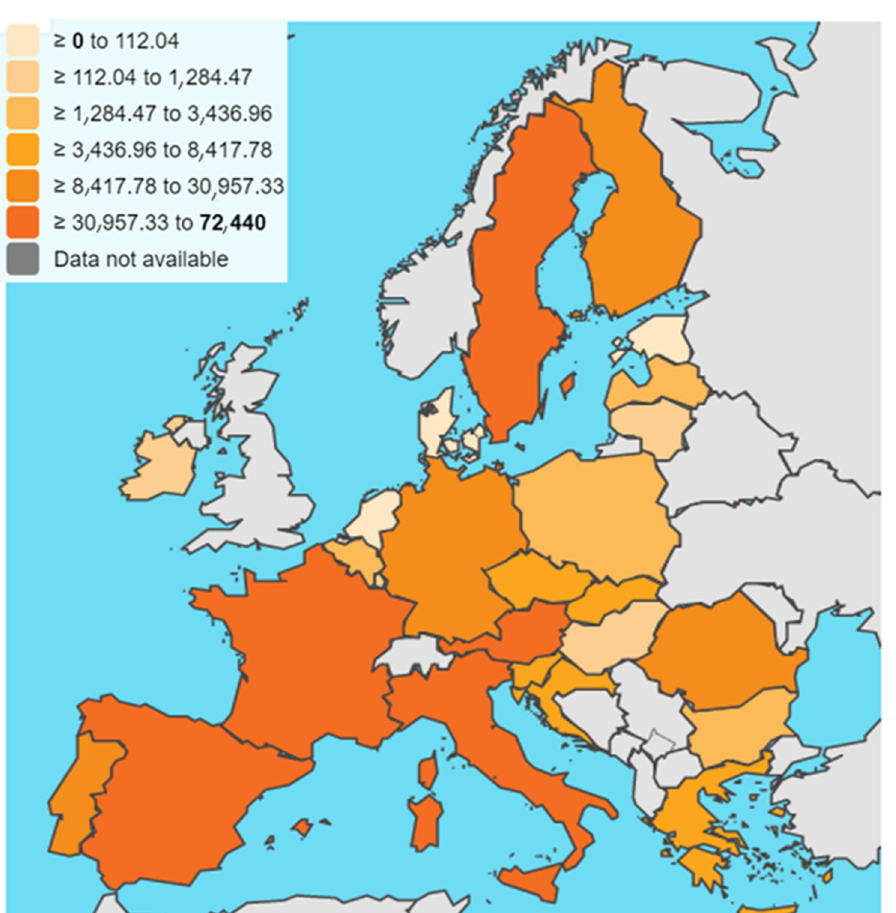
Figure 1. Generation of hydropower in UE-27 in 2020 (in GWh) [9].